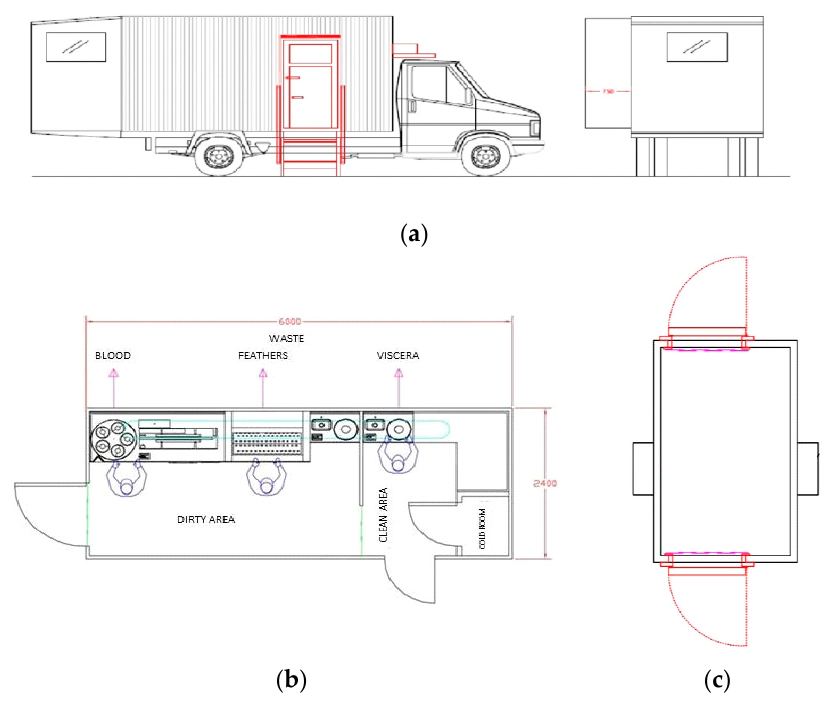
Figure 1. Schematic layout of the Mobile Poultry Processing Unit (50 chickens/hour): external ( a ) and internal ( b ) configuration and refrigerated trailer ( c ).